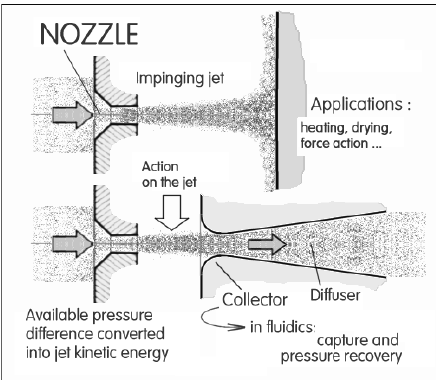
Fig. 3. There are applications with complicating effects caused by a device exposed to the jet flow. Fortunately, the impingement (top) and jet-capturing-collector flows (bottom) do not contribute significantly to pressure difference across the nozzle — the problem discussed here.